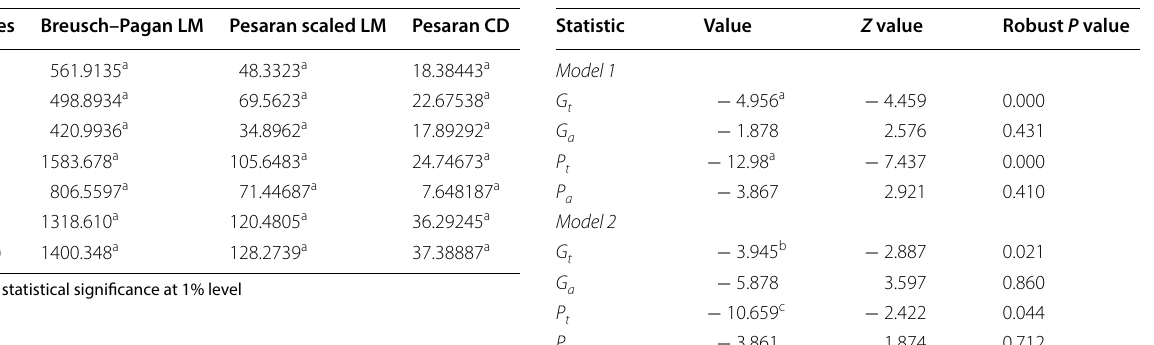
Table 5 Unit root results